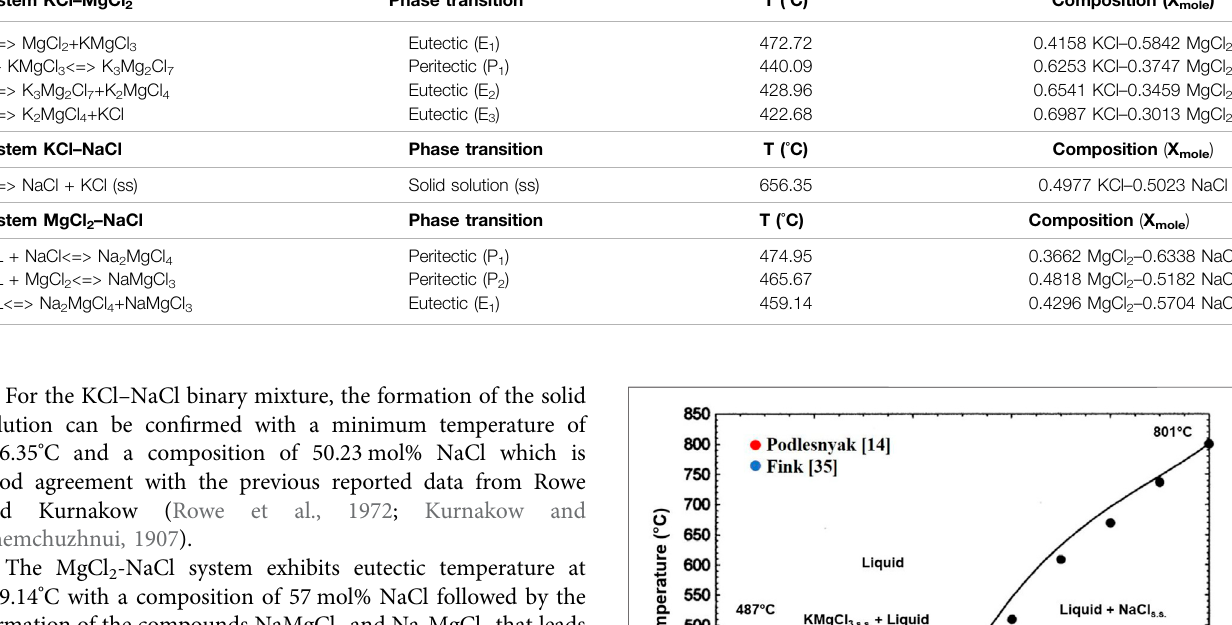
TABLE 1 | Invariant reactions of KCl – MgCl 2 , KCl – NaCl, and MgCl 2 – NaCl using FactSage thermodynamic simulation (L: Salt liquid). System KCl – MgCl 2